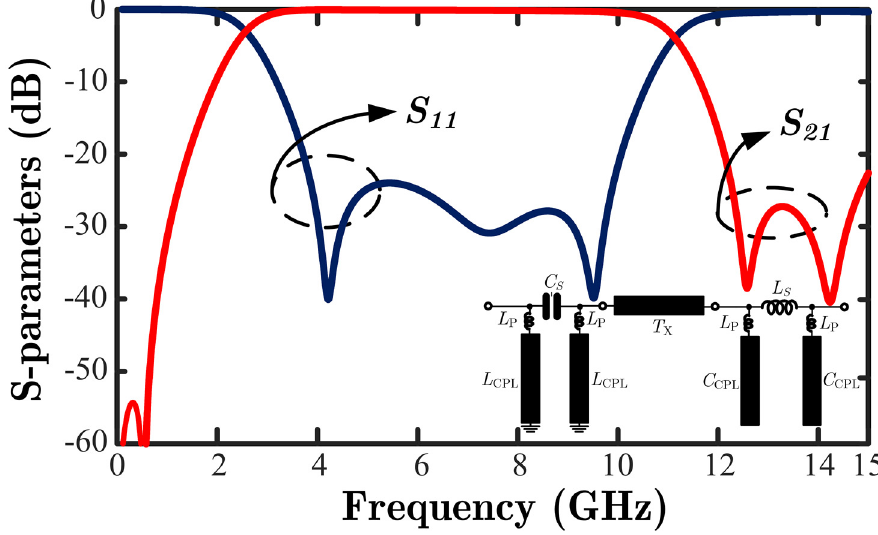
Figure 6. The results of the UWB-BPF with compensated inductors using computer simulations.